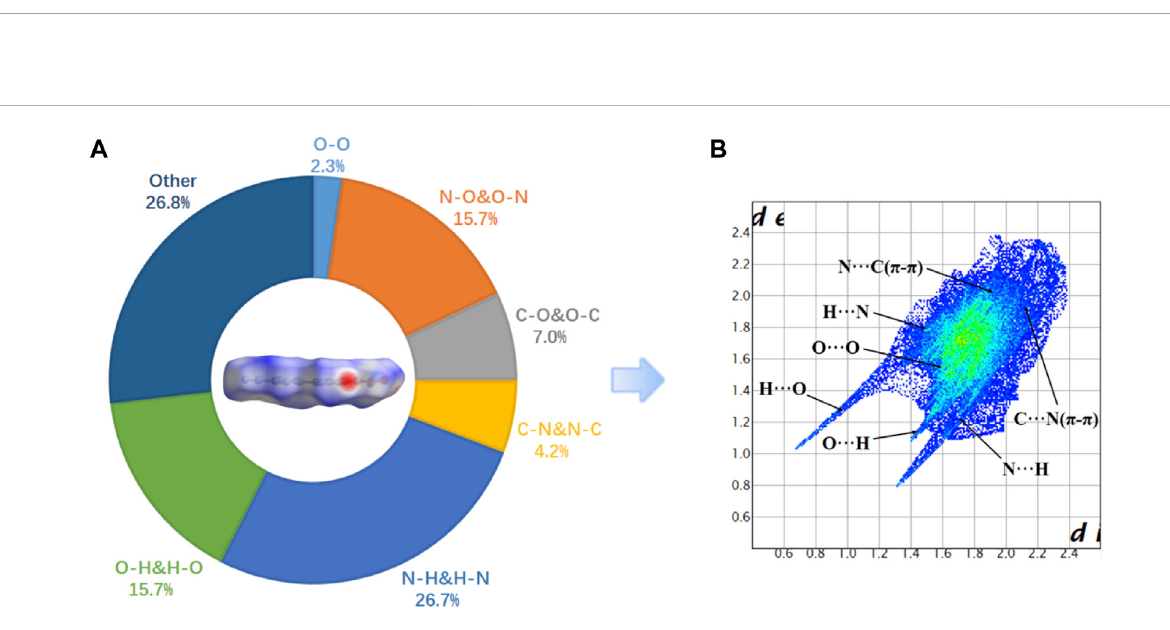
FIGURE 3 (A) Hirshfeld surface and the percentage contribution of every atomic contact for 5; (B) fi ngerprint plot for